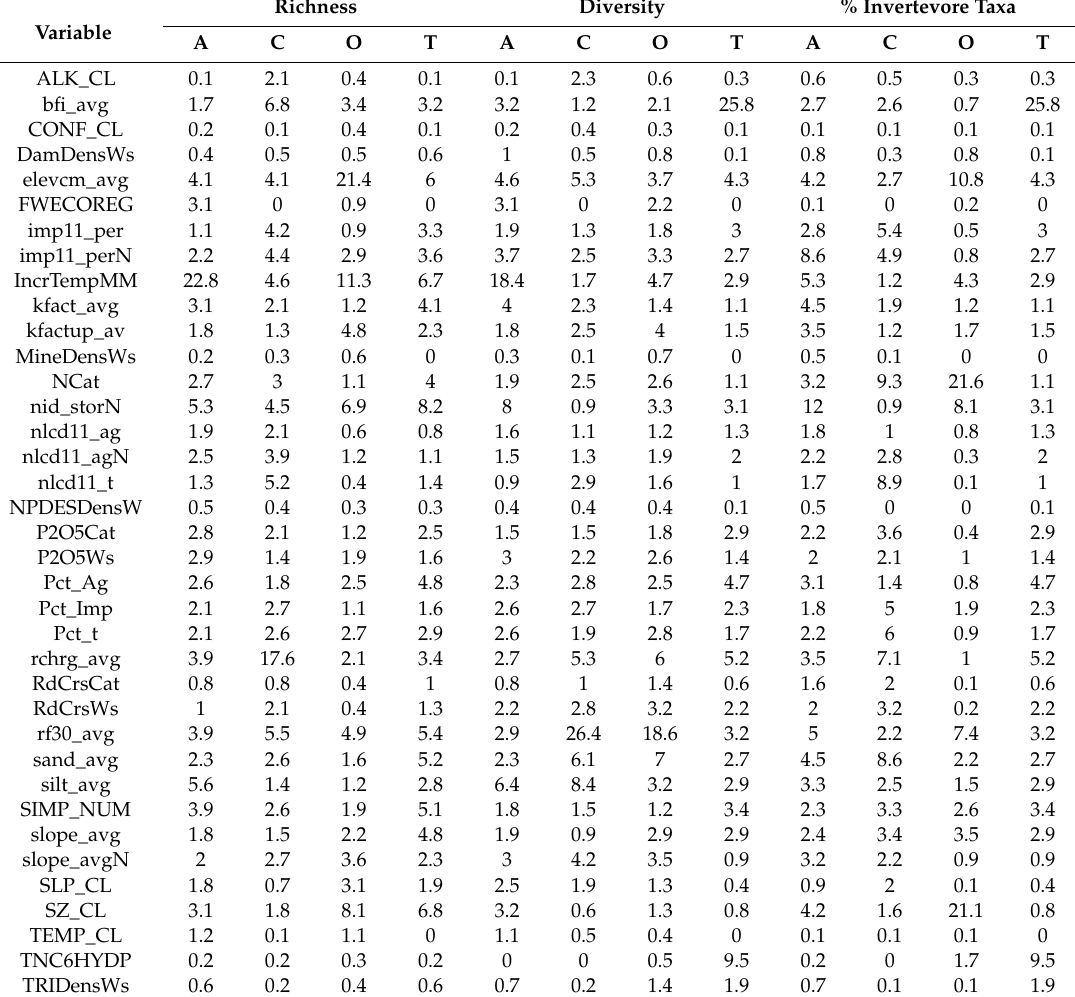
Table 6. Summary of the relative influence within each region of each predictor variable on the response variables for fish. A = Atlantic Slope, C = Cumberland River Basin, O = Ohio River Basin, and T = Tennessee River